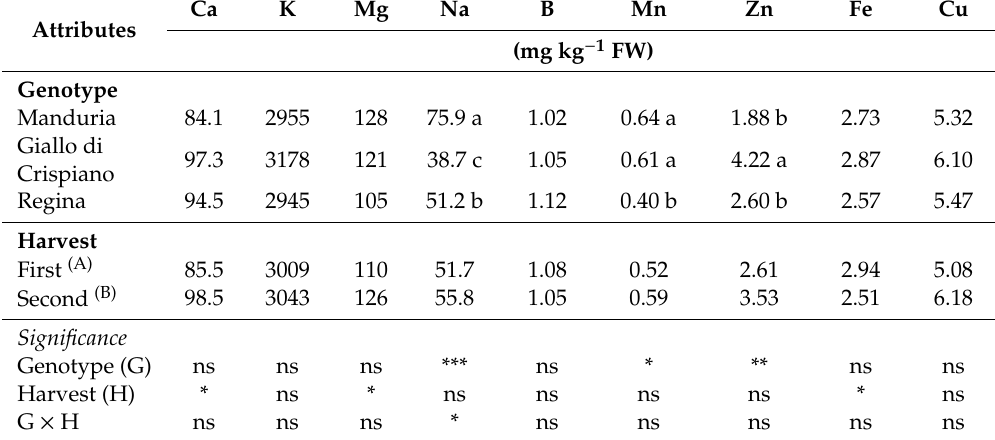
Table 6. Main e ff ects of genotype and harvest time on mineral content of tomato